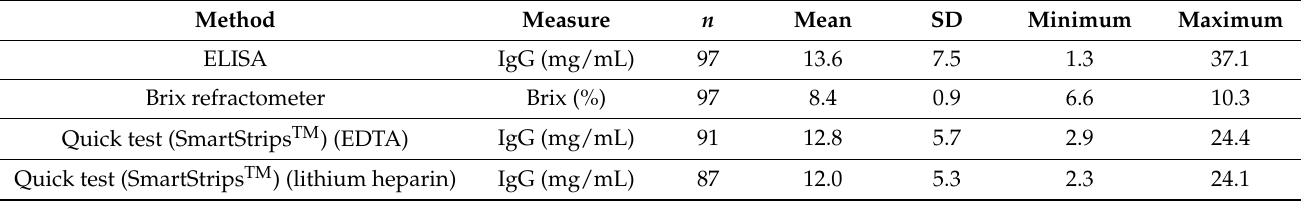
Table 2. Descriptive statistics of blood samples used in analyses.